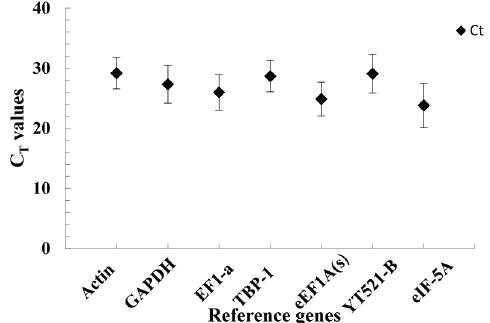
Figure 3. The C T values of seven reference genes in annual ryegrass for all samples (the filled diamond symbol refers to the median C T values of leaves and roots under salt stress, and the bars show the standard deviation).